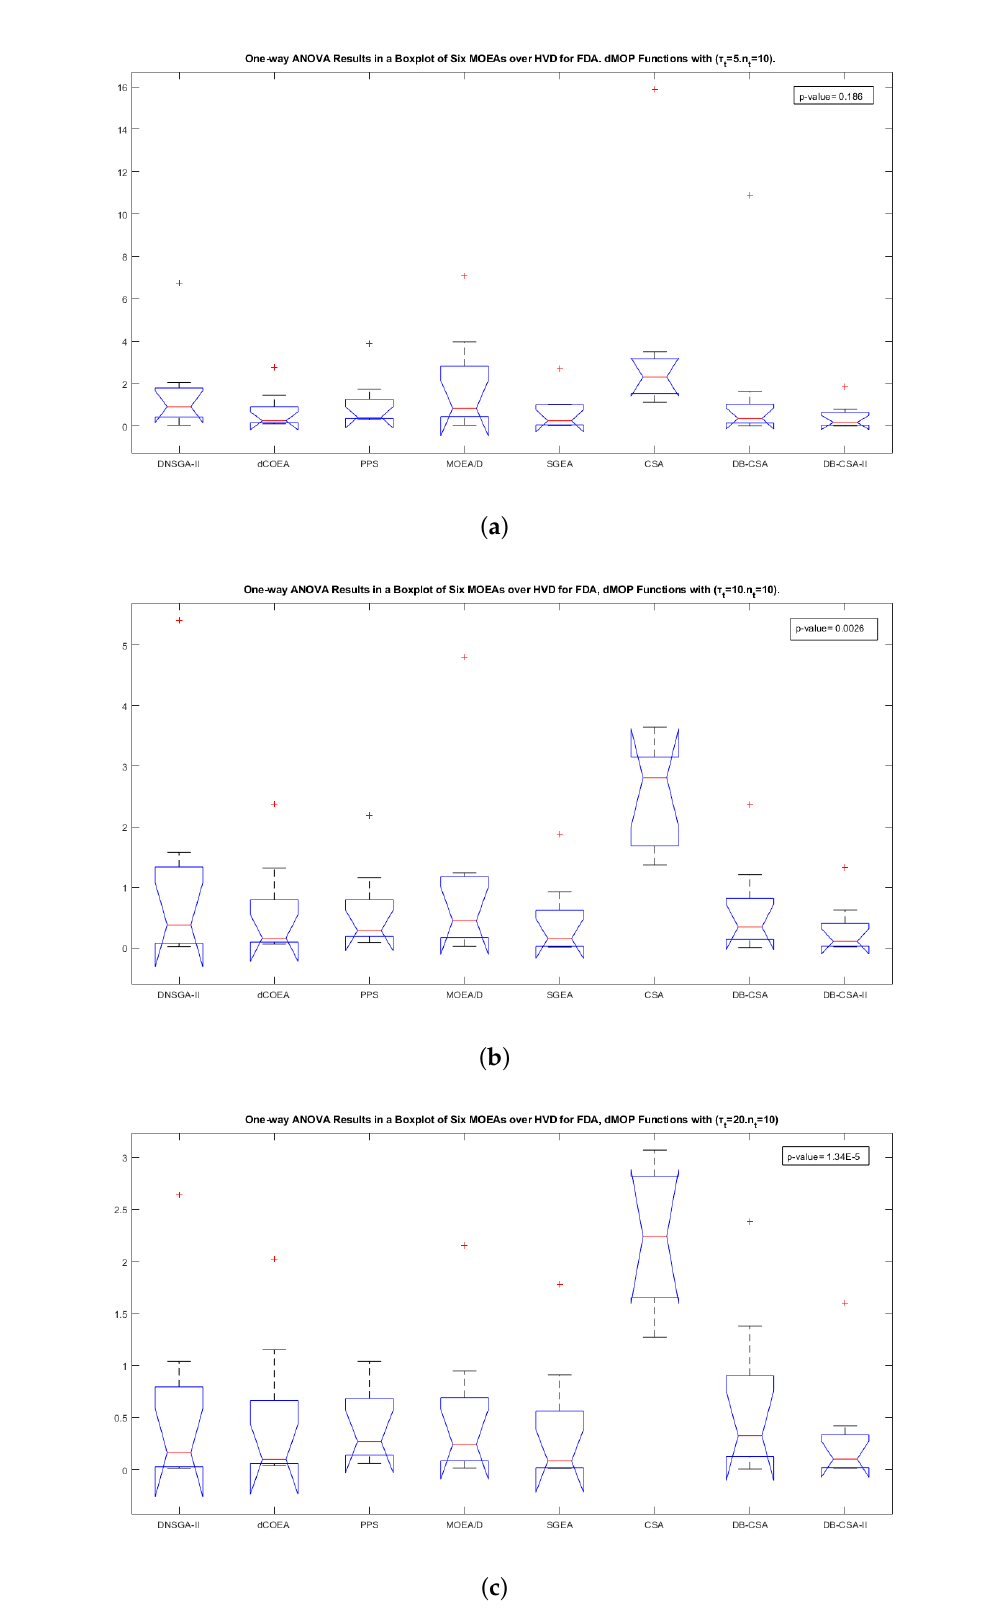
Figure 7. One-way ANOVA Box-plots of 6 MOEAs over HVD of FDA, dMOP for ( a ) severe with ( τ t = 5, n t = 10), ( b ) moderate ( τ t =10, n t = 10), and ( c ) slight ( τ t = 20, n t = 10) environmental changes,